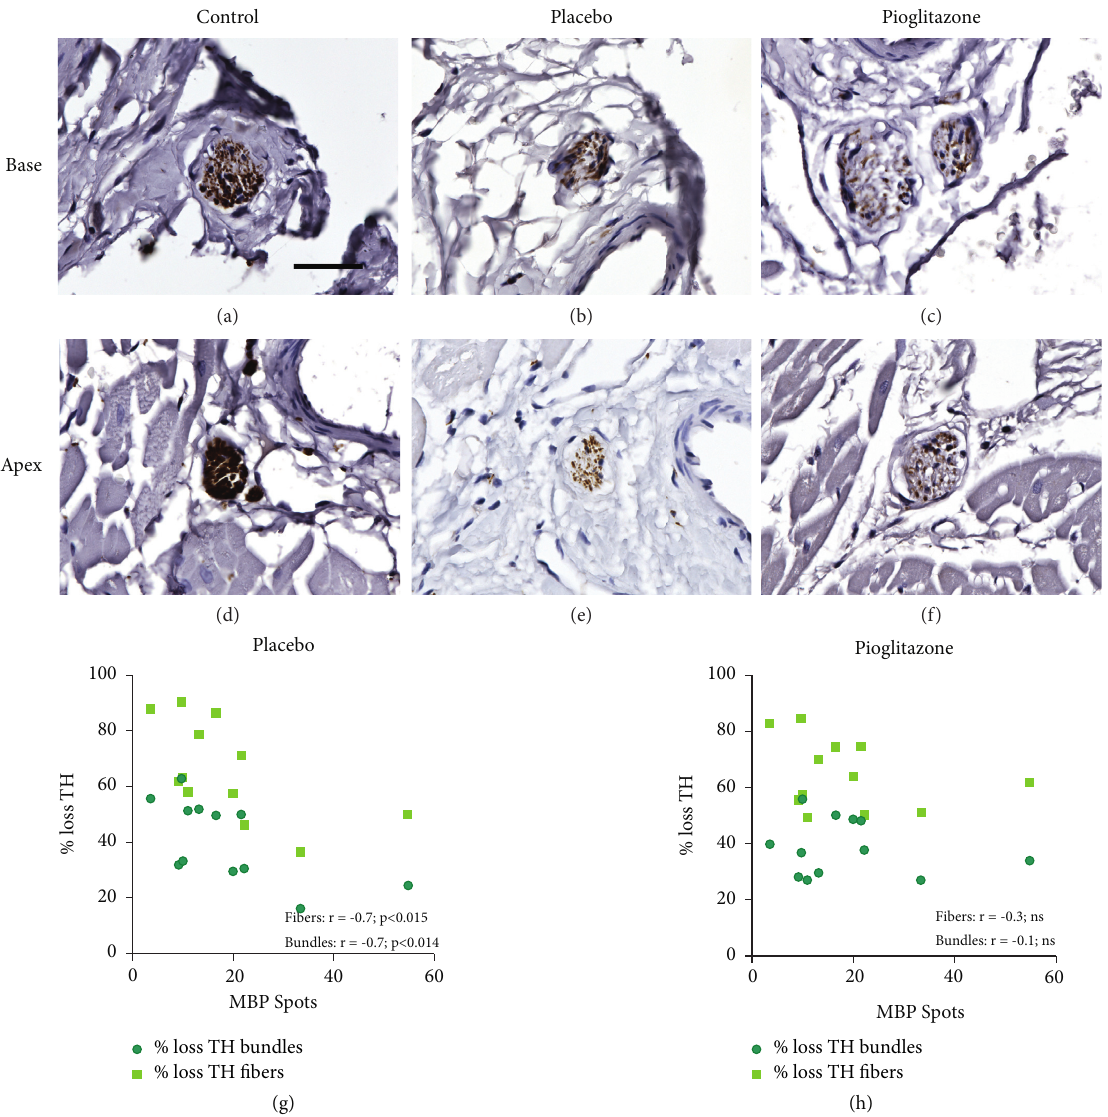
Figure 5: Sympathetic axon loss inversely correlates with the amount of myelin present across cardiac anatomy in placebo- but not pioglitazone-treated animals. Photomicrographs (a–f) of TH-immunoreactivity (-ir) in myocardial nerve bundles in the cardiac base (a–c) or apex (d–f) level in normal control (a, d), 6-OHDA+placebo-treated (b, e), or 6-OHDA+ pioglitazone-treated (c, f) animals. Scale � 25 μ m. Plots (g, h) of the relationship between MBP-ir spot number and either TH-ir loss in nerve bundles (TH bundles) or loss of TH-ir fibers in the myocardium (TH fibers) in each of the 12 cardiac anatomical areas (3 levels ∗ 4 regions). MBP-ir spot counts are the average (mean) of the control animals. Percent loss of TH-ir in bundles and fibers is the percent difference between the control group average and the 6-OHDA+ placebo (g) or 6-OHDA +pioglitazone (h) group average. MBP, myelin basic protein; TH, tyrosine hydroxylase; pio, pioglitazone; ns, not